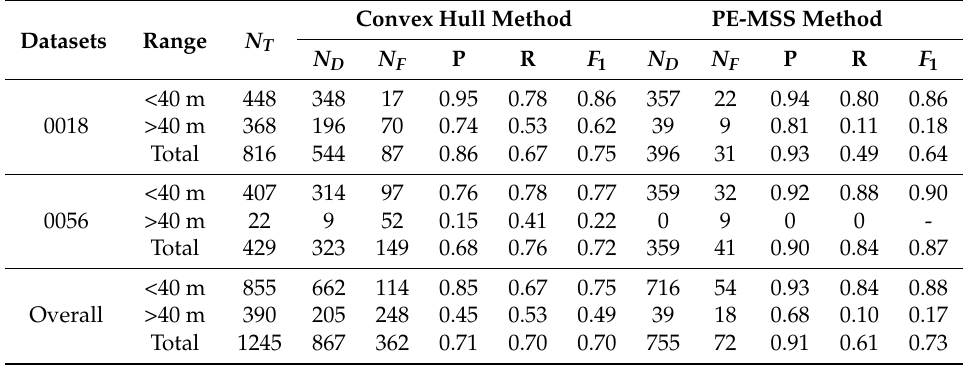
Table 1. Dynamic vehicle detection results by the convex-hull model method and pose estimation with modified scaling series (PE-MSS) method.